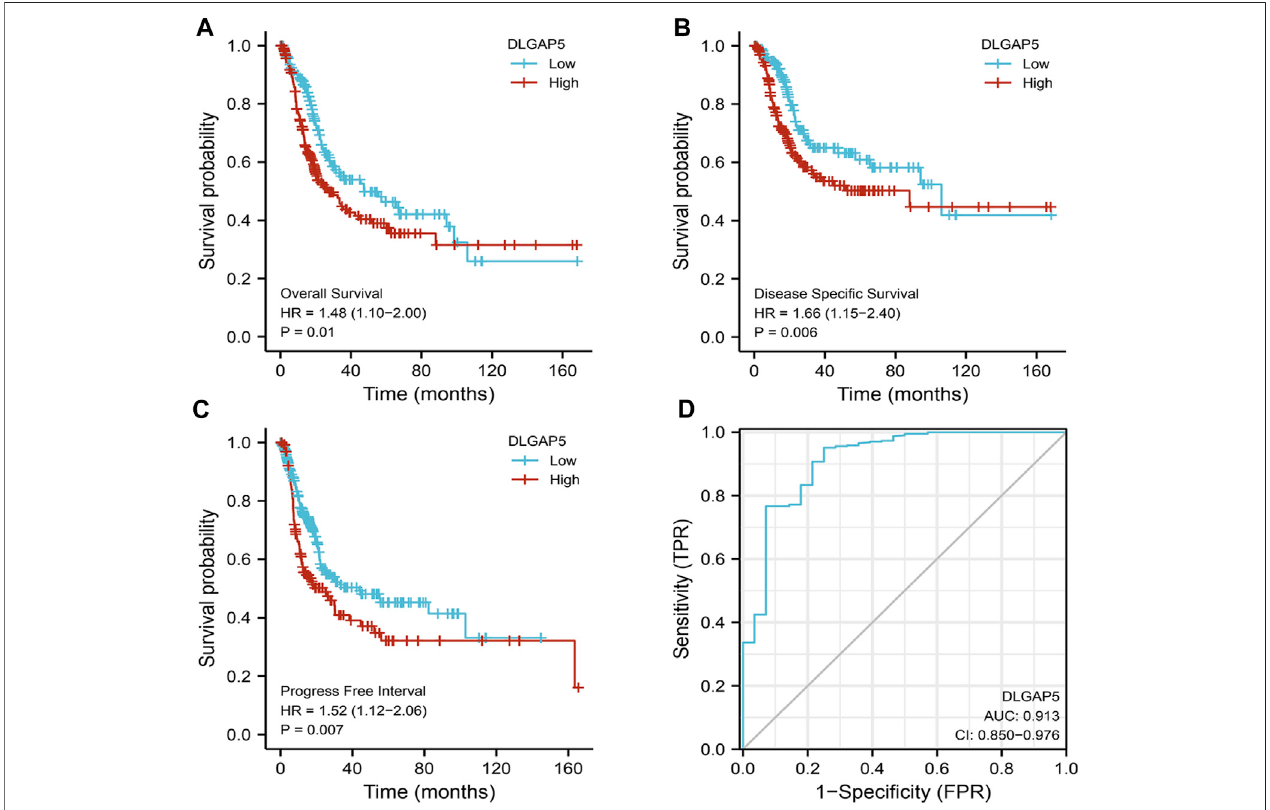
FIGURE2| ThediagnosticandprognosticanalysisOfDLGAP5. (A) HighDLGAP5hadworseoverallsurvival(OS)forbladdercancerpatients(p=0.01,HR=1.48). (B) Thebladder cancer patients withhigh expression ofDLGAP5 had worse disease speci fi csurvival (DSS) (p= 0.006, HR= 1.66). (C) The bladder cancer patients with high expression of DLGAP5 had worse progress free interval (DFI) (p = 0.007, HR-1.52). (D) The diagnostic analysis of DLGAP5 in bladder cancer patients. the area under the ROC curve (AUC) was 0.913, CI: 0.850 – 0.976. When the p < 0.05, the result was regarded as statistical signi fi cance.